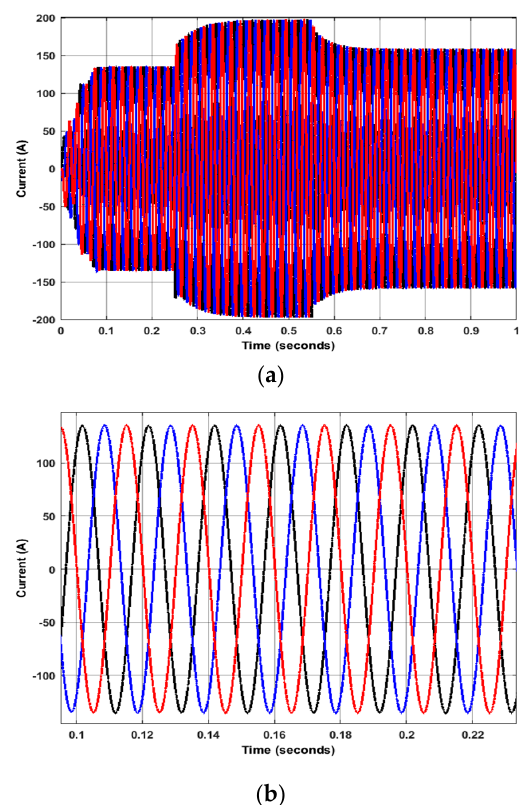
Figure 10. Three-phase sinusoidal current waveform ( a ) complete operation ( b ) zoomed version from 0.1–0.22 s.